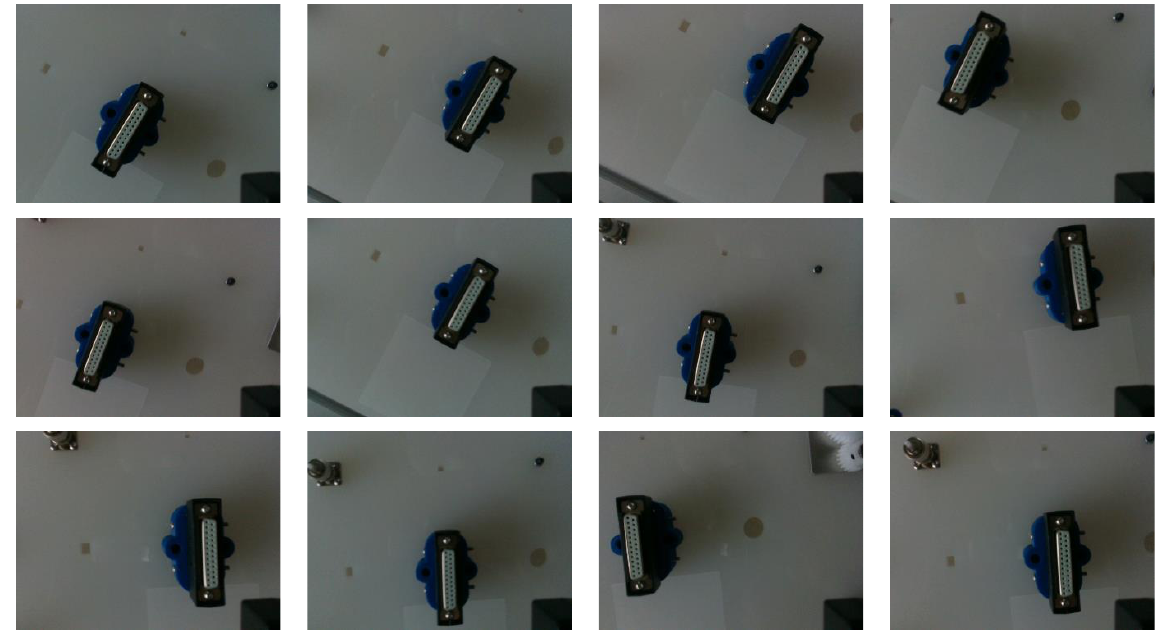
Figure 14. Dataset of D-sub Connector.